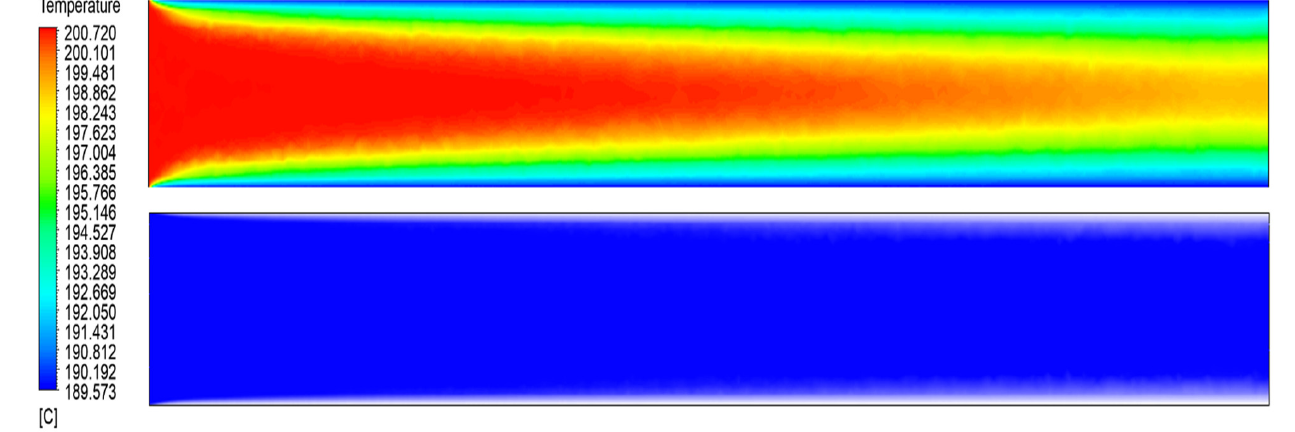
Figure 14. Temperature ( top ) and liquid fraction ( bottom ) contours of the melted filament going through the nozzle from the microchannel simulation.